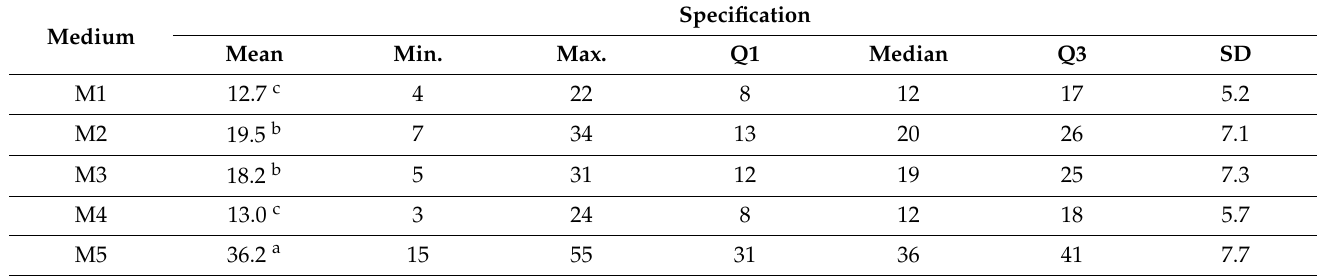
Table 1. Statistical description (mean, maximum, minimum, Q1—the first quartile, median, Q3 —the third quartile, SD—standard deviation) of several newly emerged plants in used multiplication media.